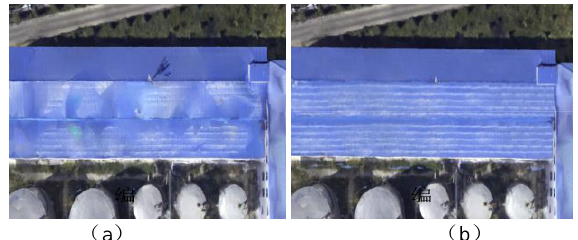
Figure 14 ． The effect of the restoration of uneven color on the roof (a) before, (b) after.